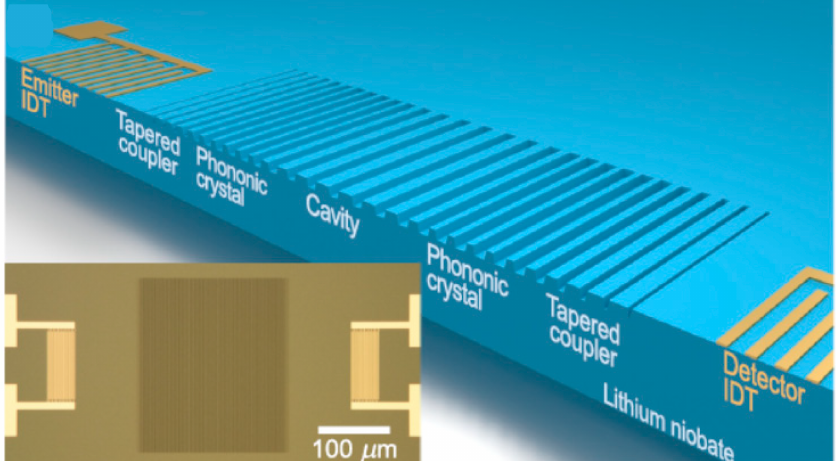
Figure 6. Illustration of band structure engineered surface acoustic resonator on LiNbO 3 . Inset: optical microscope image of a fabricated device. The dark region at the center is the etched grooves, and the bright regions on the sides are metal IDTs